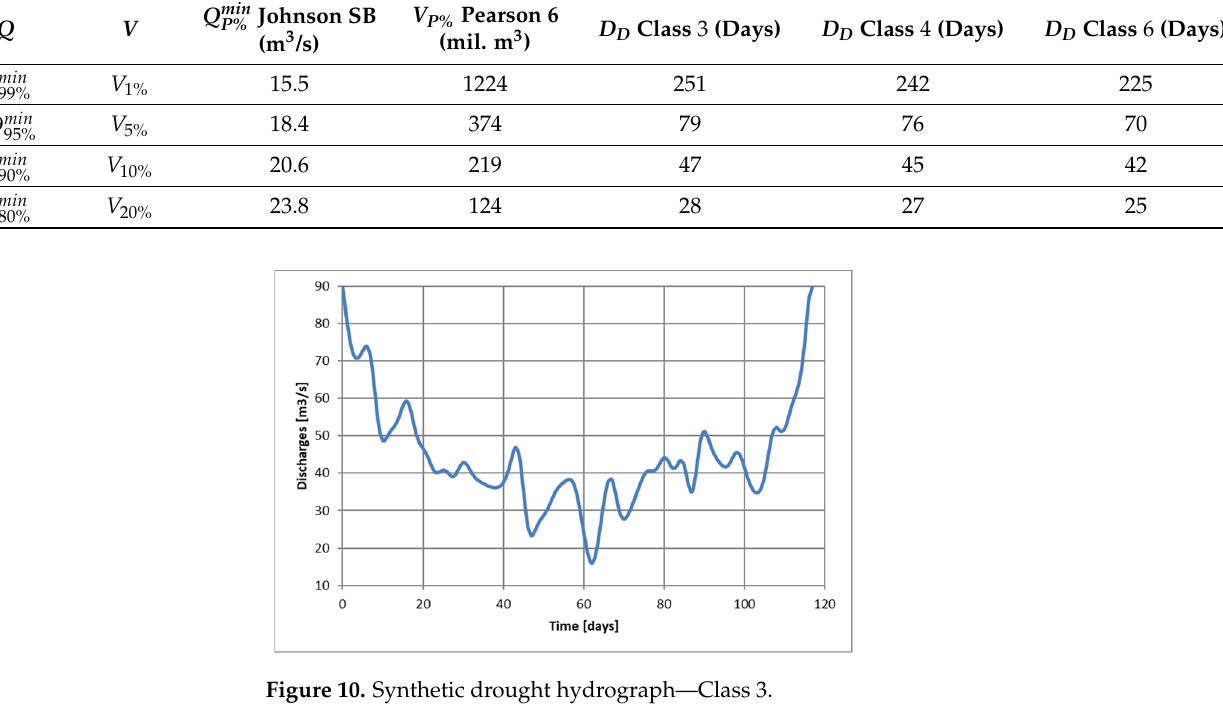
Table 4. SDHs parameters for Johnson SB and Pearson 6 distributions.